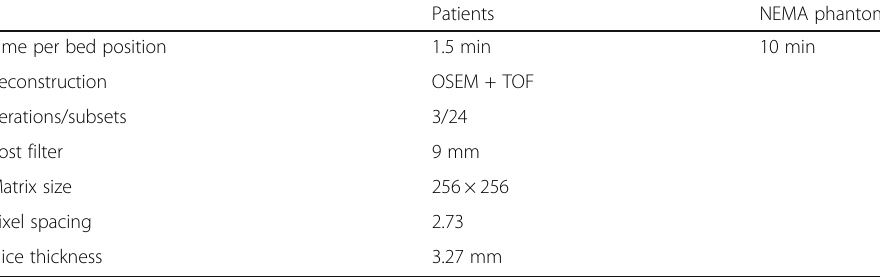
Table 1 EARL PET acquisition and reconstruction